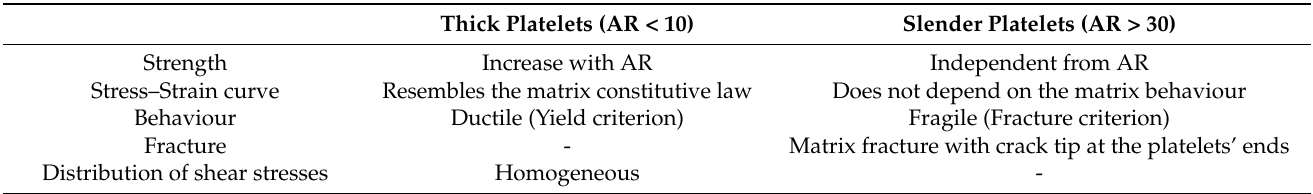
Table 4. Dependence of mechanical behaviour on nanoplatelet aspect ratio. Thick Platelets (AR < 10) Slender Platelets (AR > 30) Strength Increase with AR Independent from AR Stress–Strain curve Resembles the matrix constitutive law Does not depend on the matrix behaviour Behaviour Ductile (Yield criterion) Fragile (Fracture criterion) Fracture - Matrix fracture with crack tip at the platelets’ ends Distribution of shear stresses Homogeneous